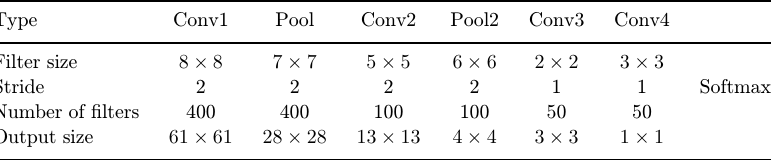
Table 1. The proposed CNN architecture (images input 128 (cid:1) 128 ).